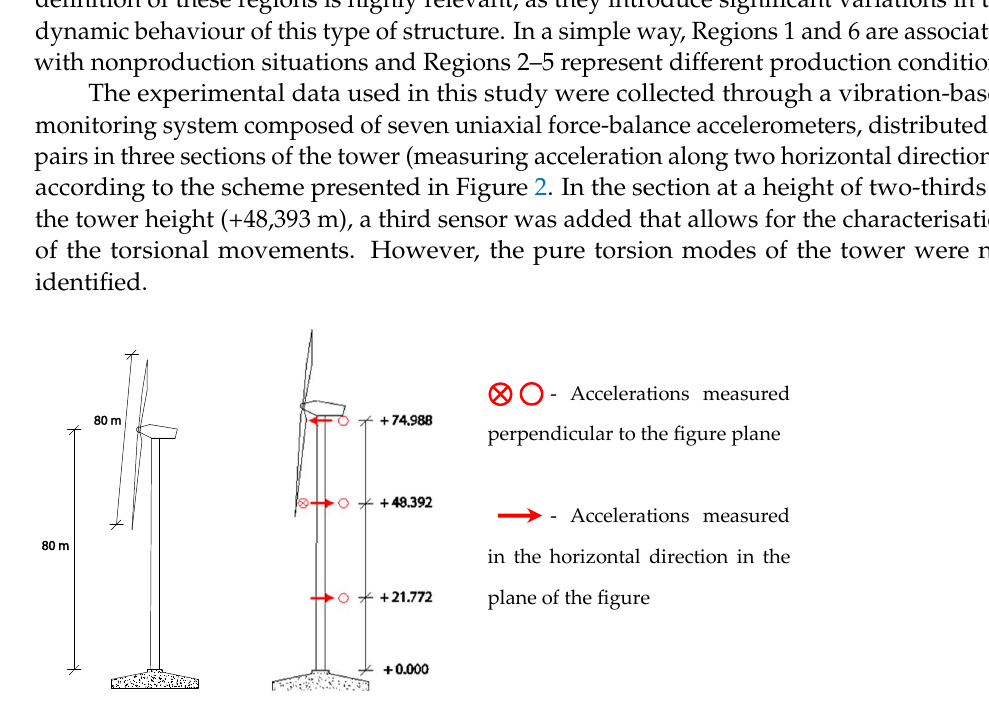
Figure 2. Position of the accelerometers at three levels of the wind turbine tower.